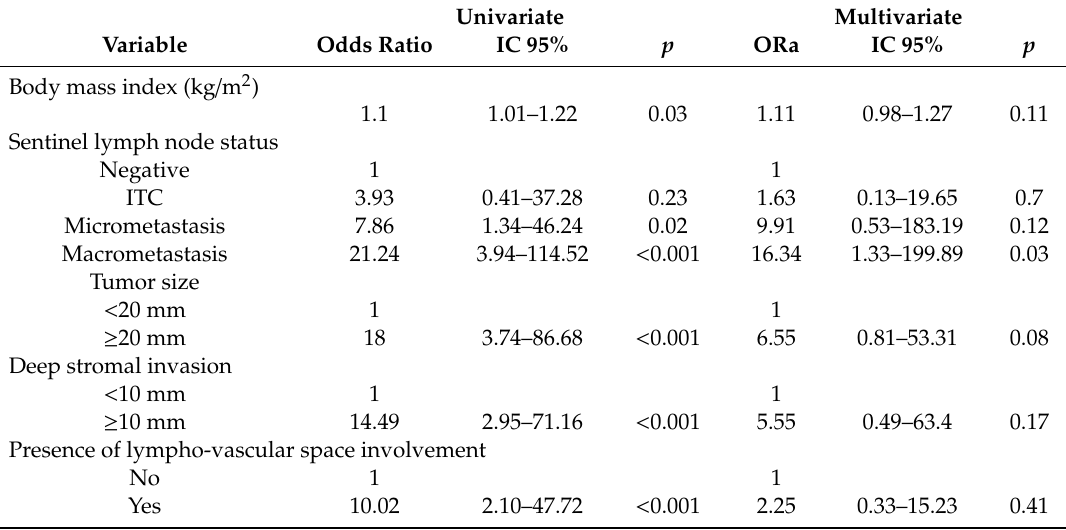
Table 2. Univariate and multivariate analysis of predictive factors associated with parametrial involvement. Univariate Multivariate